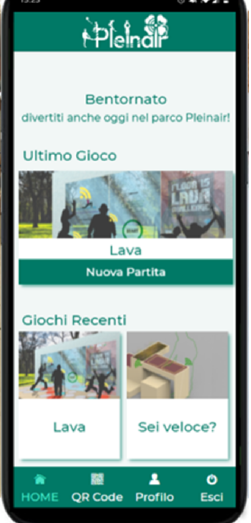
Figure 13. Web application screenshot.